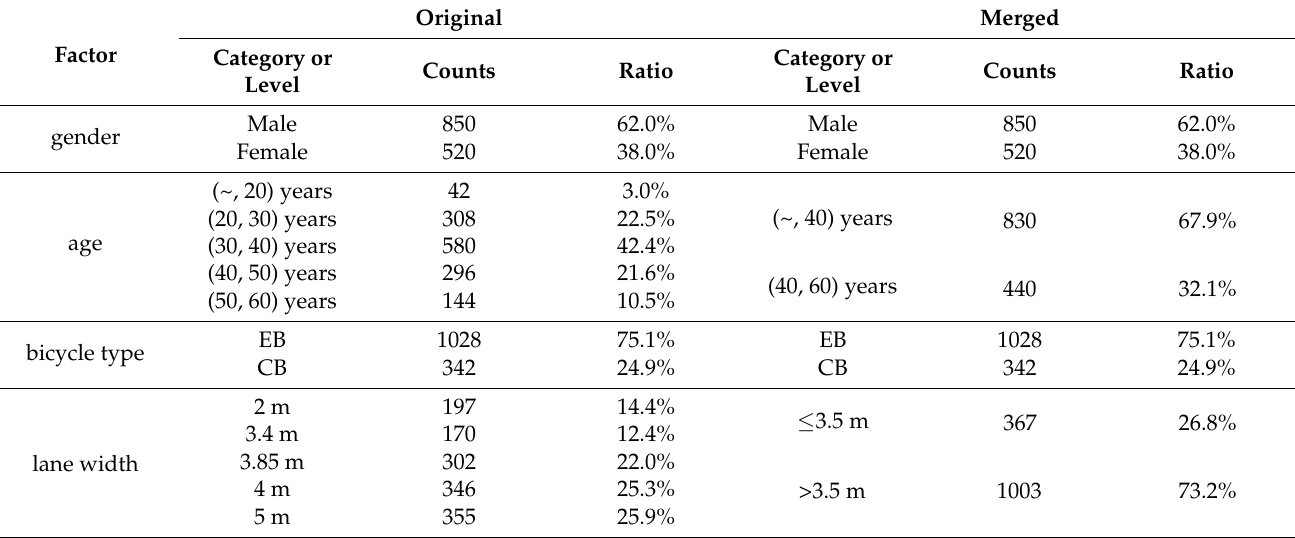
Figure 1. Histograms for Speed Data and the bimodality coefficient (value exceeding 0.555 are taken to indicate bimodality and conversely not). Table 1. Basic characteristics of the original and level-merged field survey